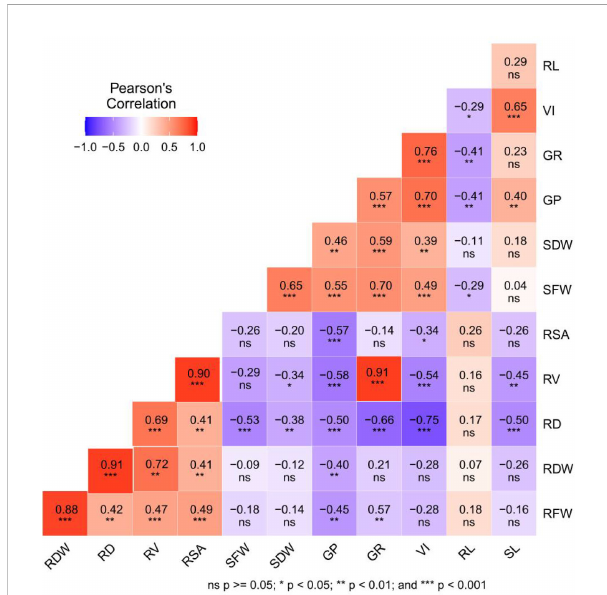
FIGURE 7 Correlation heat map among the seed germination rates and the root and shoot attributes using R software. RL, root length; SL, shoot length; RFW, root fresh weight; RDW, root dry weight; SFW, shoot fresh weight; SDW, shoot dry weight; RD, root diameter; RV, root volume; RSA, root surface area; GR, germination rate; GP, germination potential; VI, vigor